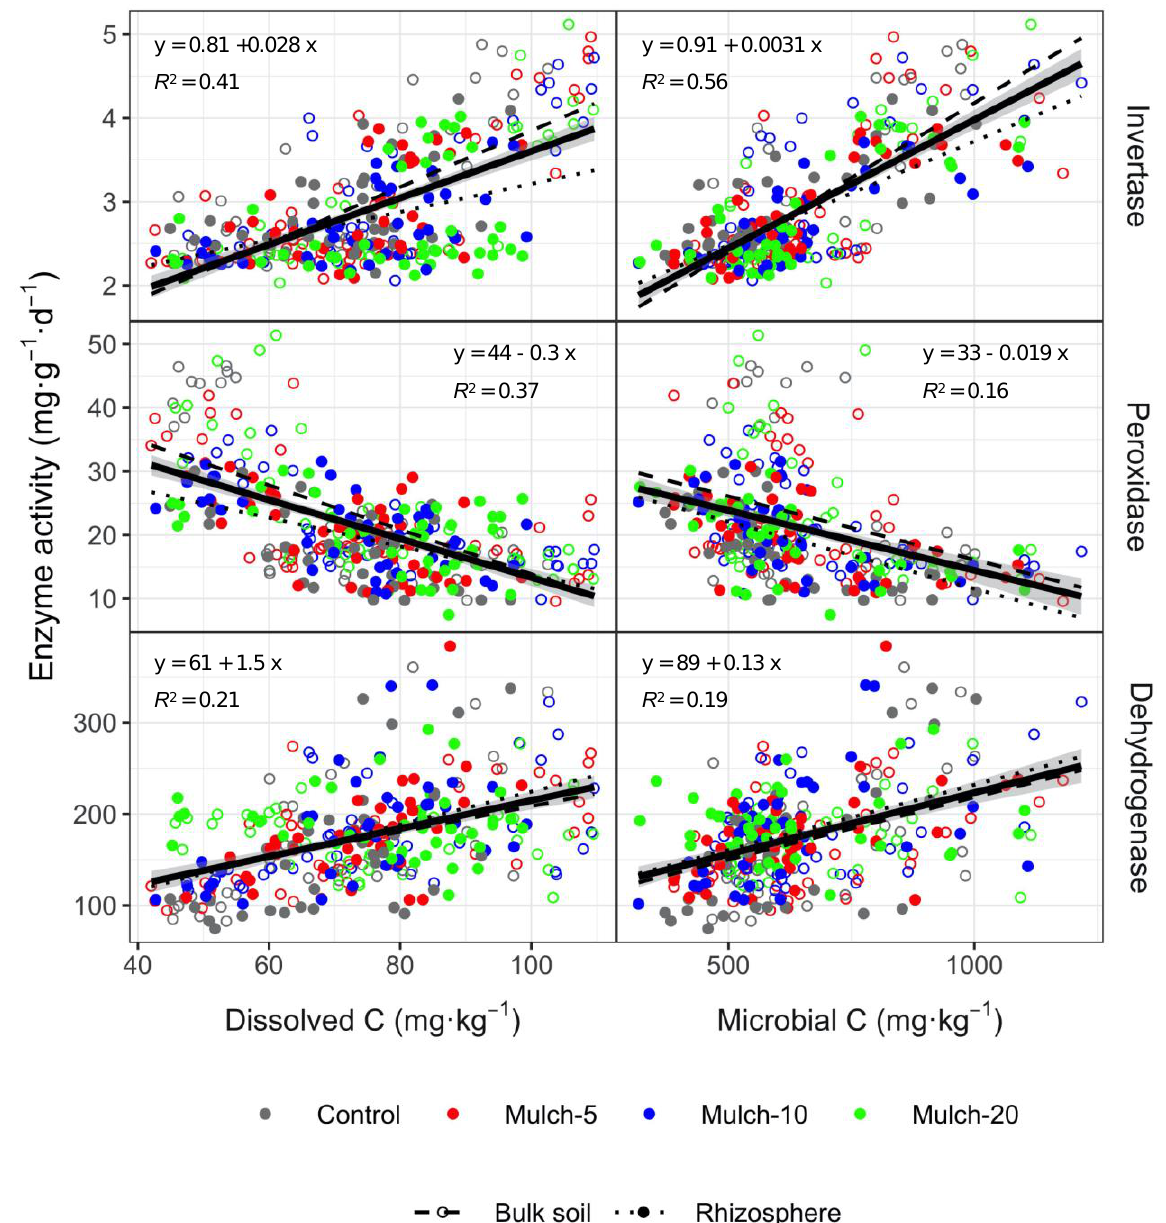
Figure 6. Regression analysis for the effects of dissolved C and microbial C on enzyme activity. All regression lines are significant at p < 0.01. The black continuous line with shaded area shows the regression and 95% confidence interval for all points.